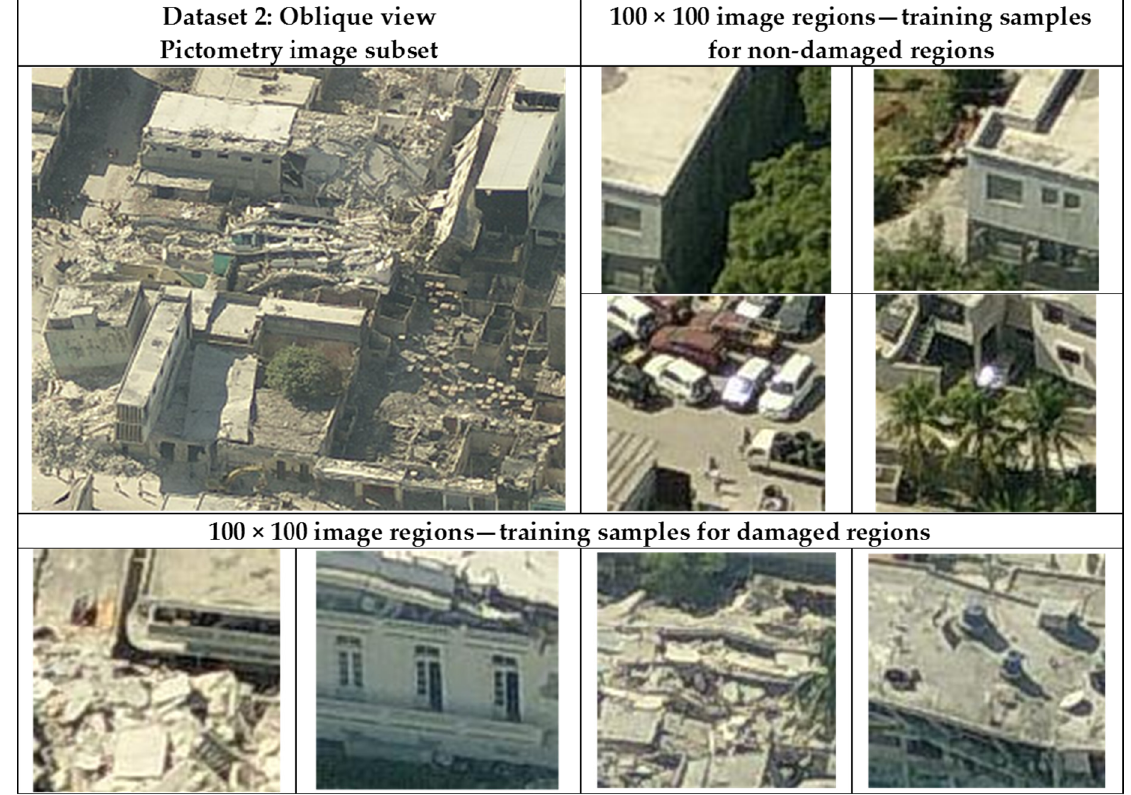
Figure 5. Samples of image patches in dataset 2, images © Pictometry. Table 4. Performance of feature descriptors when associated with different learning algorithms for dataset 2, comprising patches from Pictometry images (training samples = 879, testing samples = 377).